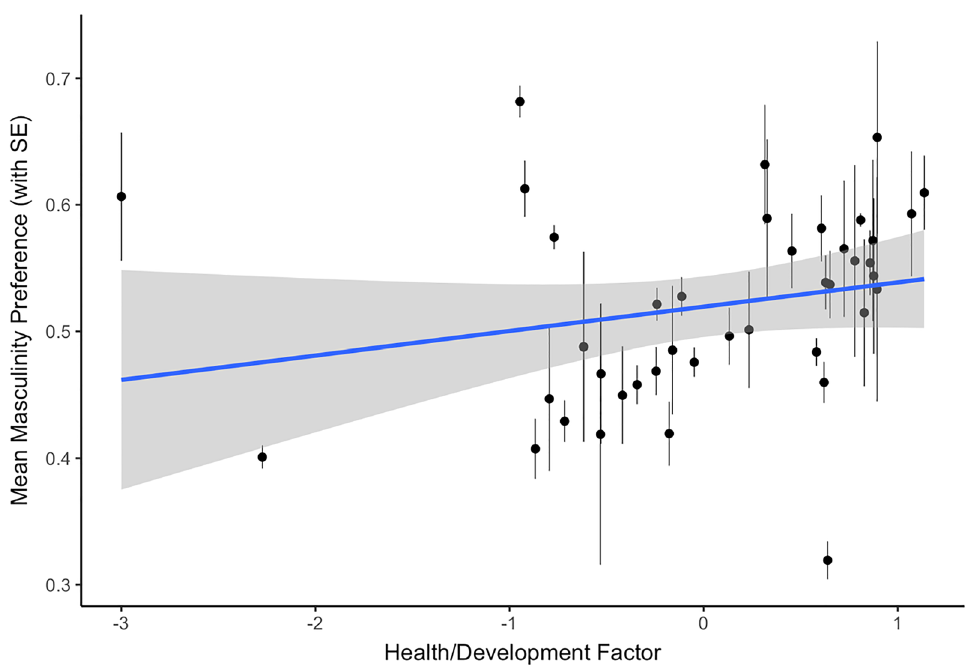
Figure 2. The significant association between scores on the health/development factor and women’s preferences for male facial